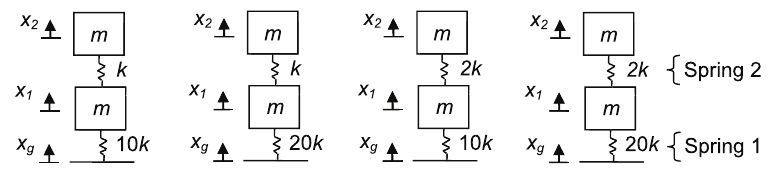
Fig. 1. Base-excited, two DOF systems (from left to right, structures